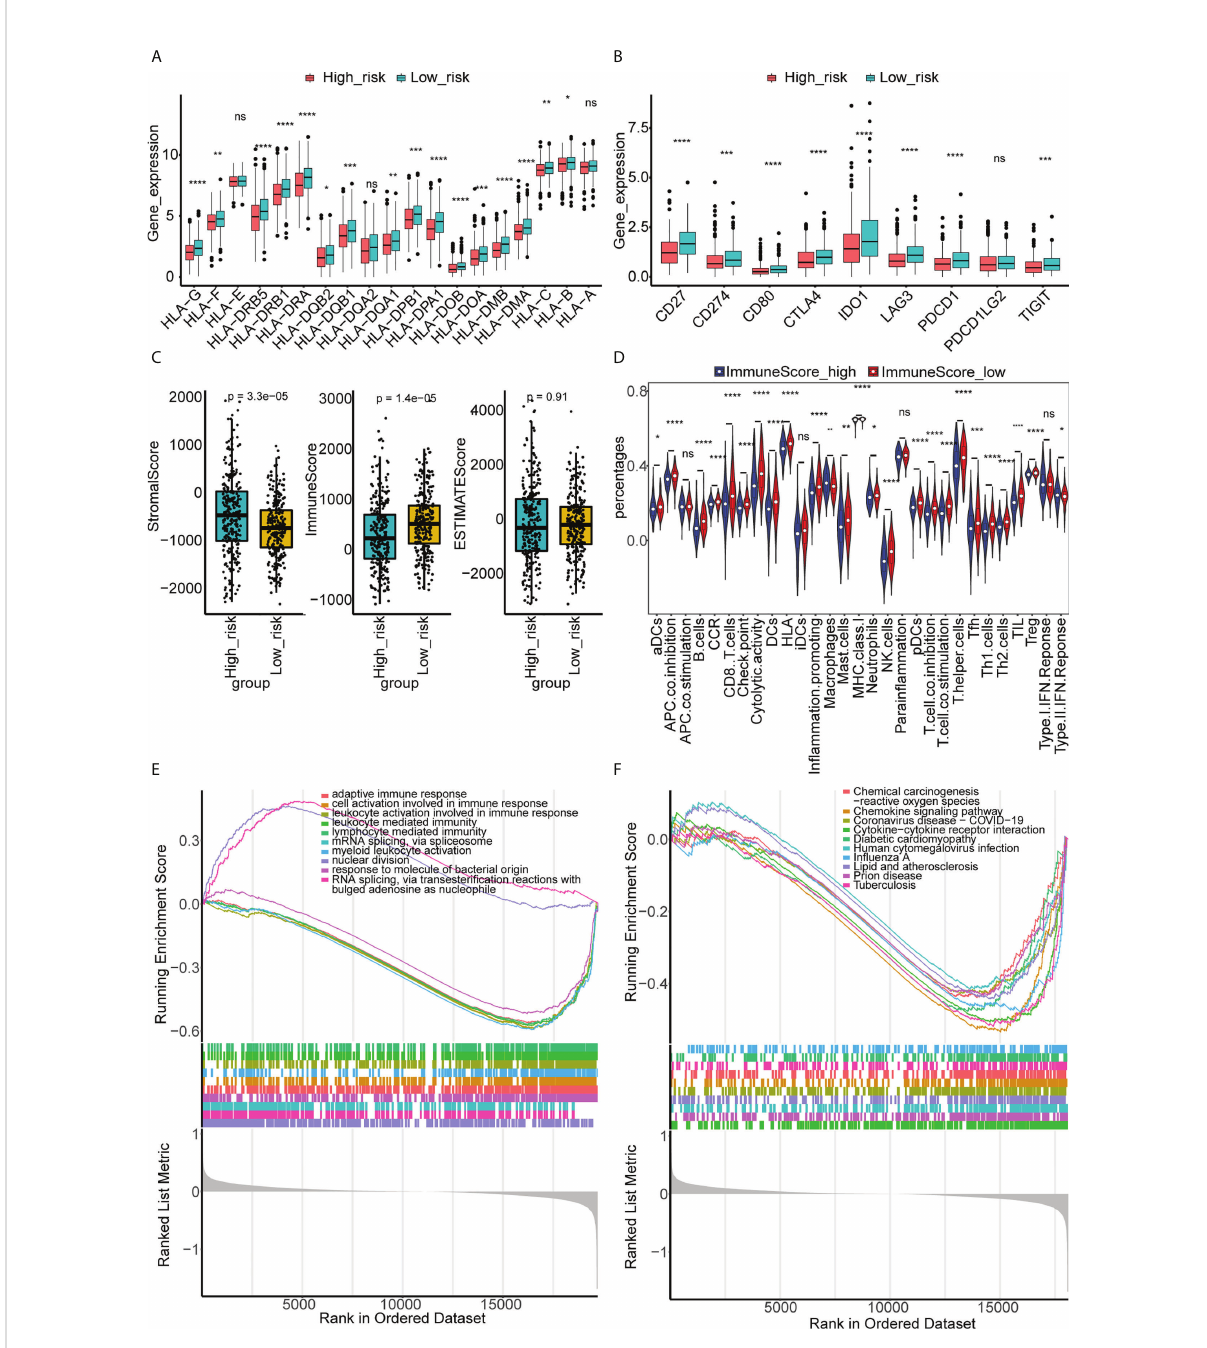
FIGURE 8 Different immune characteristics and GSEA enrichment between the high- and low-risk groups. (A) The expressions of HLA genes in the high- and low-risk groups of CRC in TCGA. (B) The expressions of immune checkpoints in the high- and low-risk groups of CRC in TCGA. (C) Immune, stromal, and ESTIMATE scores were compared between high- and low-risk groups of CRC in TCGA. (D) The abundance of 29 immune cells estimated by ssGSEA in the high- and low-risk groups of CRC in TCGA. (E) GSEA of differentially expressed genes between the high- and low-risk groups of CRC in GO terms. (F) GSEA of differentially expressed genes between the high- and low-risk groups of CRC in KEGG terms. "ns, no signi fi cance; *p< 0.05, **p< 0.01, ***p< 0.001, and ****p<